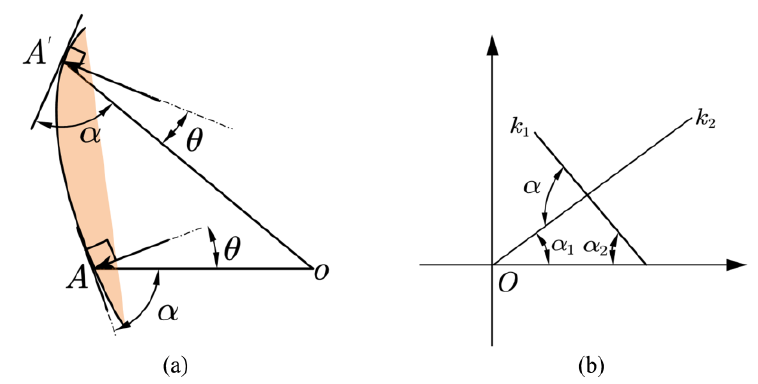
Figure 16. ( a ) Hypothetical chute curve; ( b ) Simplified model in polar coordinates. and tangent, Equation (12) can be obtained.